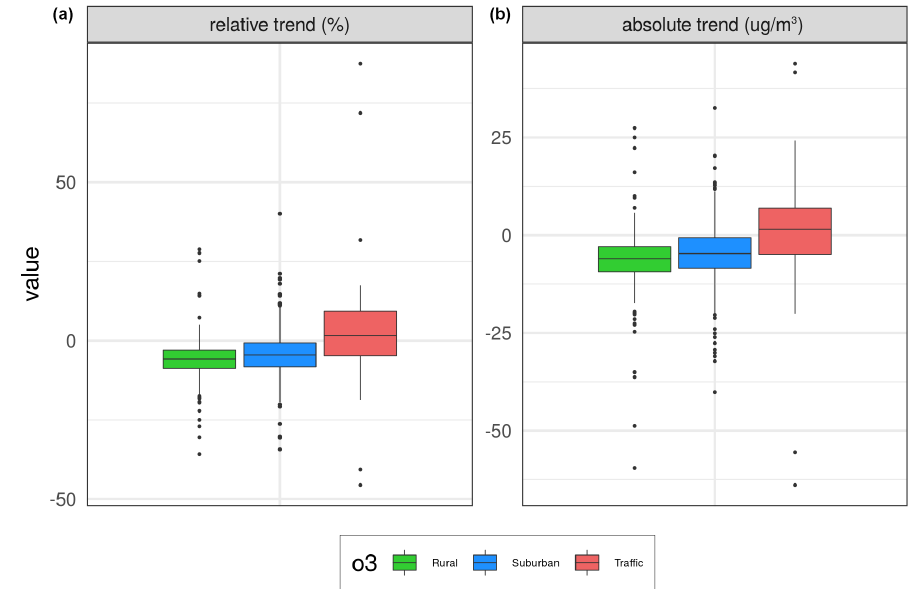
Figure 6. Box plots of changes in expected concentrations over the same three types of stations as in the map plots in Fig. 5. Panel (a) shows relative percent changes, while panel (b) shows absolute changes from 2005 to 2019 (units in % and µgm − 3